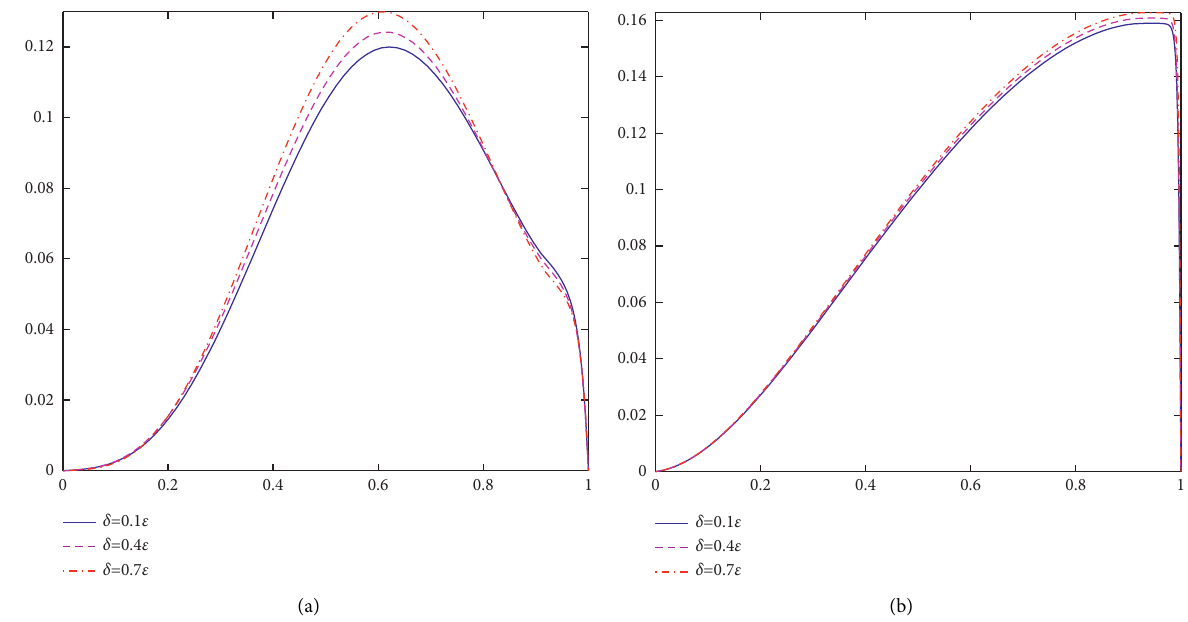
Figure 4: Effect of the delay on solution on (a) Example 1 and on (b) Example 2, for ε 2 � 2 − 5 at T � 1.